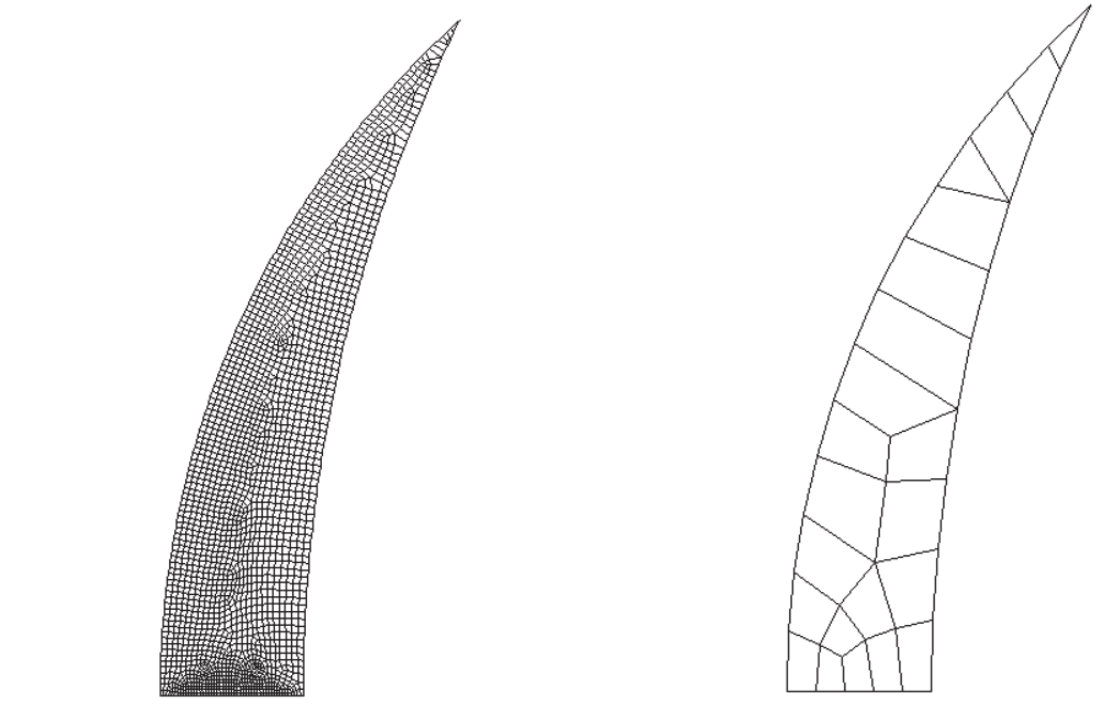
Figure 4: Strain energy density (SED) mesh sensitivity: (a) Number of elements = 2049, W = 2.8431 MJ/m 3 ; (b) Number of elements = 23, W = 2.8398 MJ/m 3